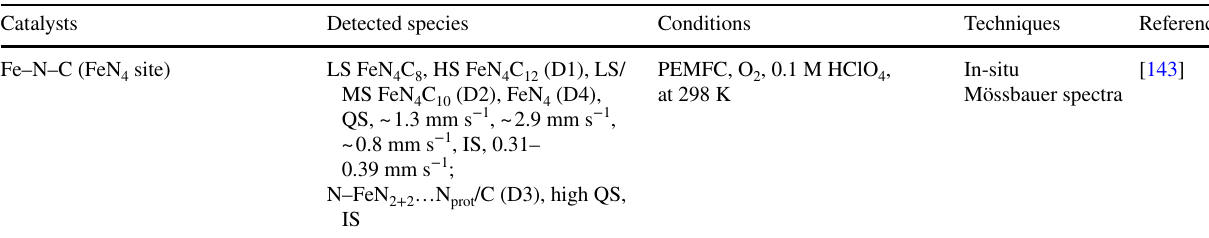
(Fig. 14e), the 557 cm −1 peak (Pt–O) was only visible at high potential, and a broad peak appeared at 0.7 V then split into the 698 cm −1 (*OOH) and 750 cm −1 peaks with decreasing potential. Combining the DFT, the 750 cm −1 peak was related to the *OH adsorbed on the Co site. Notably, the *OH signal only existed in alkaline, prov- ing that Co had a high oxygen affinity and could co-exist with Pt on the catalyst surface in alkaline, thereby resulting in worse ORR activity, contrarily, Co would leach out in acid, so without *OH signal, and with better activity. More importantly, taking *OOH as the intermediate, the pos- sible ORR process in acid solution was explored by DFT + H + + e − → *OOH, secondly, (Fig. 14f). Firstly, * + O 2 *OOH + H + + e − → *O + H O, thirdly, *O + H + + e − → *OH, 2 fourthly, *OH + H + + e − → H O. Thereinto, the energy devi- 2 ation among *O and *OH of Pt Co (blue arrow) increased 3 by 0.11 eV than pure Pt (red arrow), supporting that the adsorption of *O on Pt Co was weak, so its ORR activity 3 was higher. Further based on DFT (left bottom inset), this phenomenon was caused by the strain effect, and the lat- tice constant of Pt Co decreased by 2.3%. In summary, this 3 work shows that the DFT can help to exactly identify the intermediate on the catalyst surface during ORR, further predicting the possible ORR mechanism. Notably, it supplies